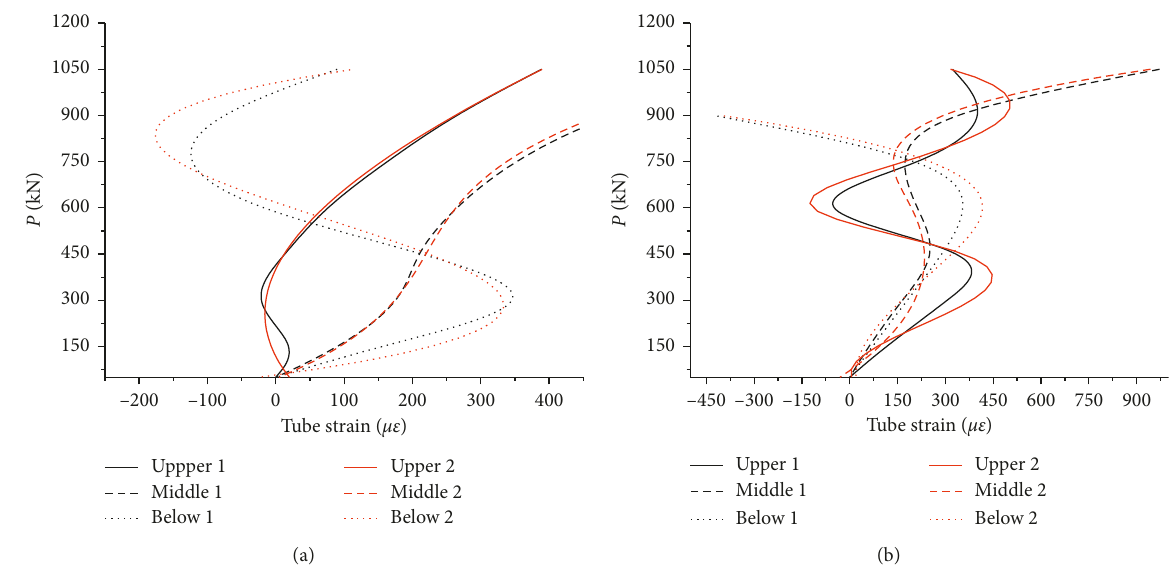
Figure 6: Compression force (P) and steel tube vertical strains relation curves: (a) Z650; (b)